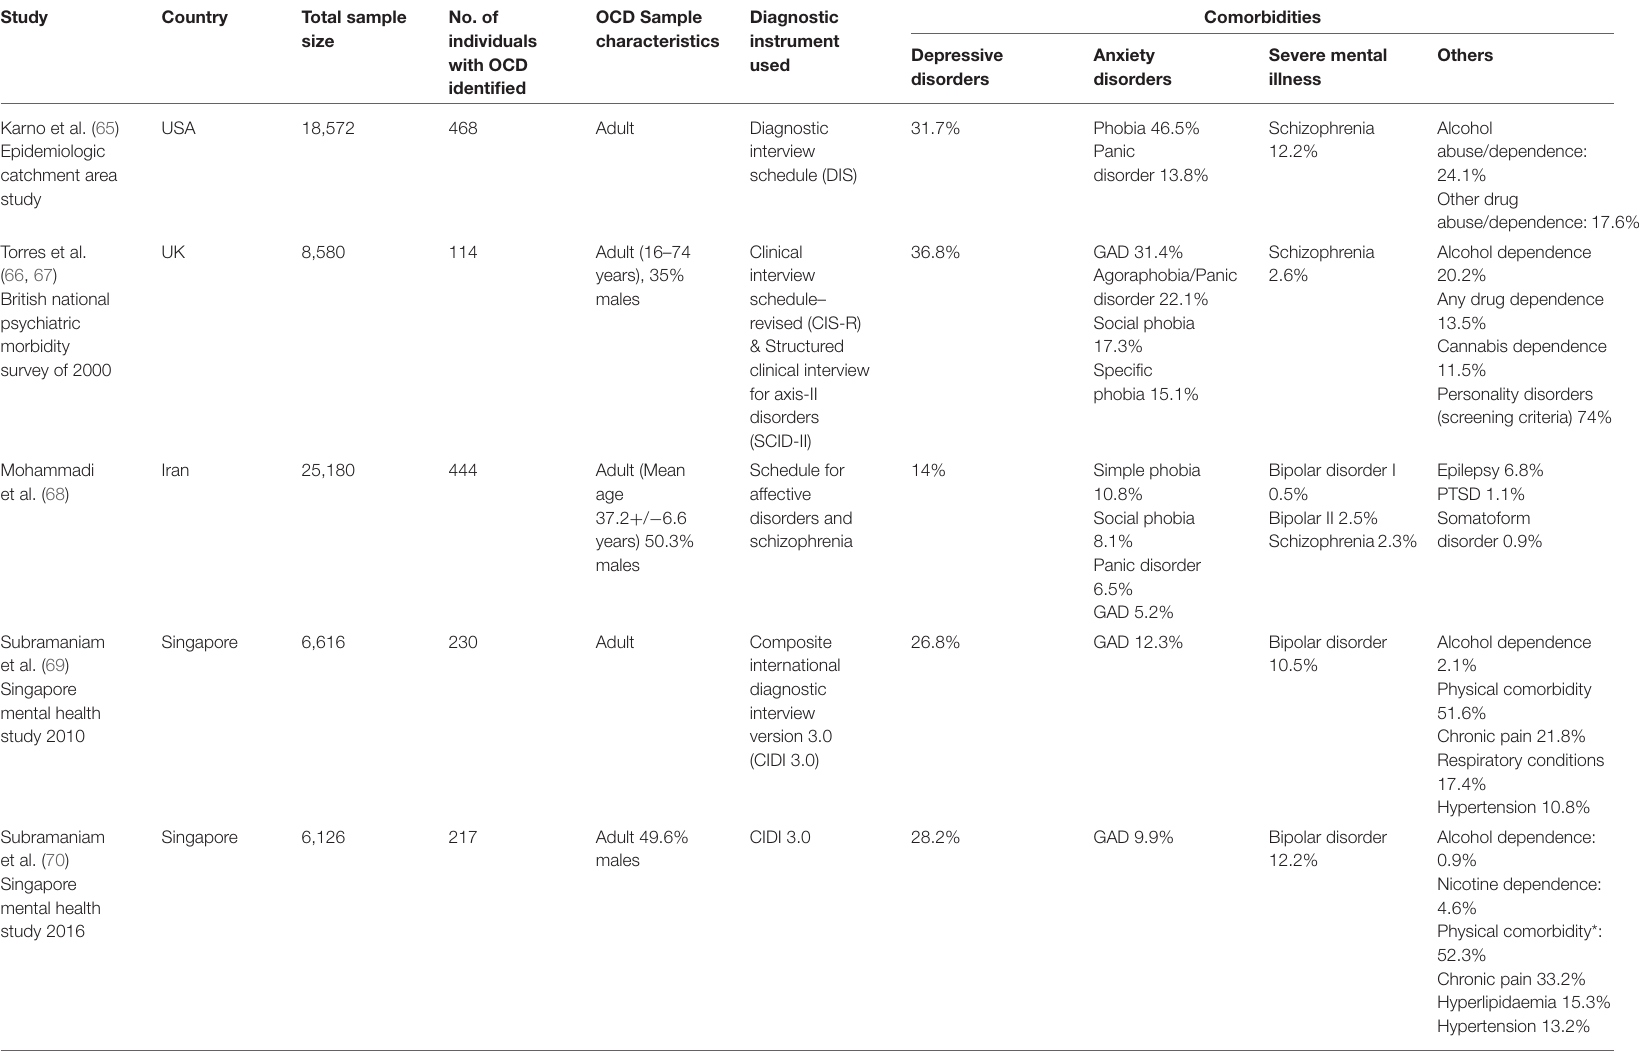
TABLE 3 | Prevalence of comorbidities in obsessive-compulsive disorder in community surveys.